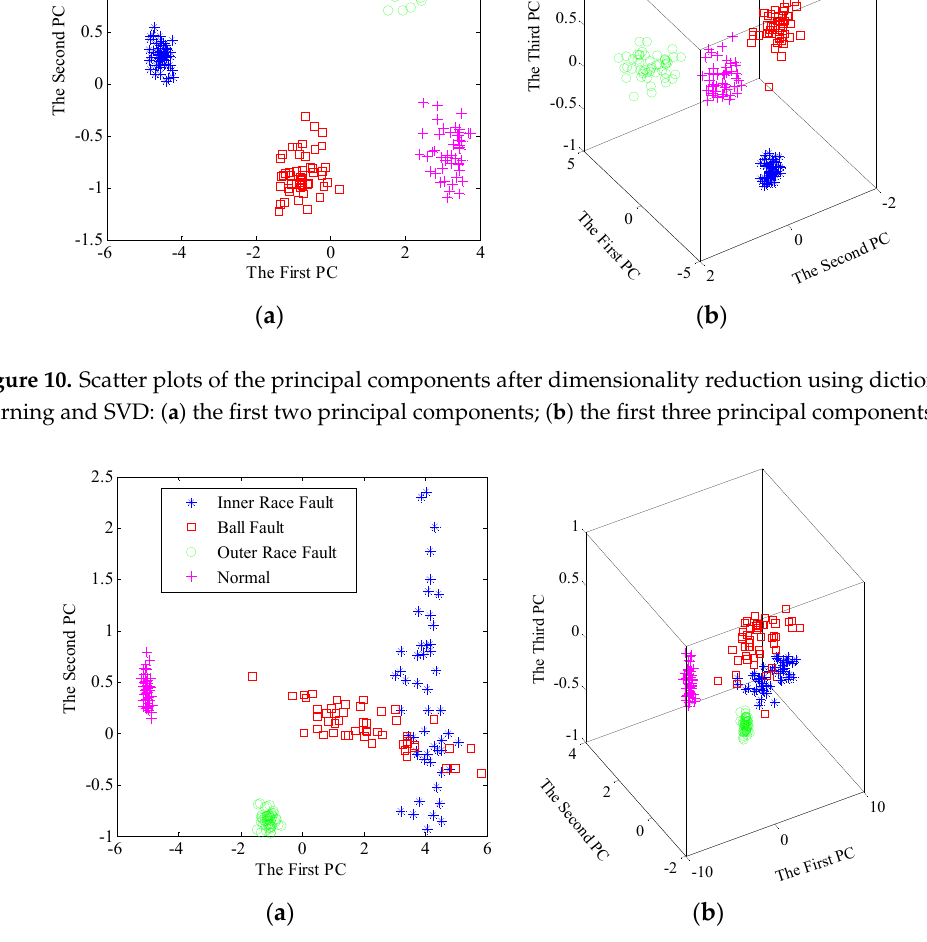
Figure 11. Scatter plots of the principal components after dimensionality reduction using EMD and SVD: ( a ) The first two principal components; ( b ) The first three principal components.